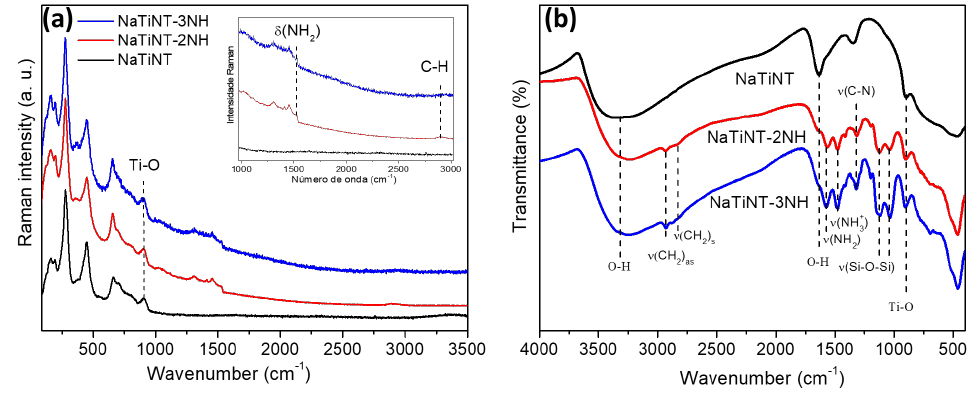
Figure 3. ( a ) Raman spectra and FTIR spectra ( b ) of NaTiNT, NaTiNT − 2NH, and NaTiNT −